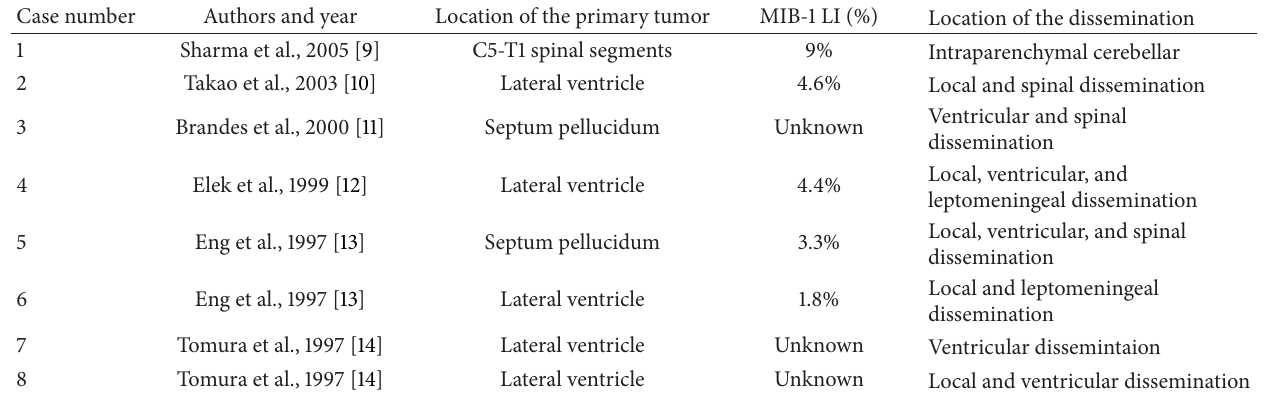
Table 1: Reported cases of neurocytoma with